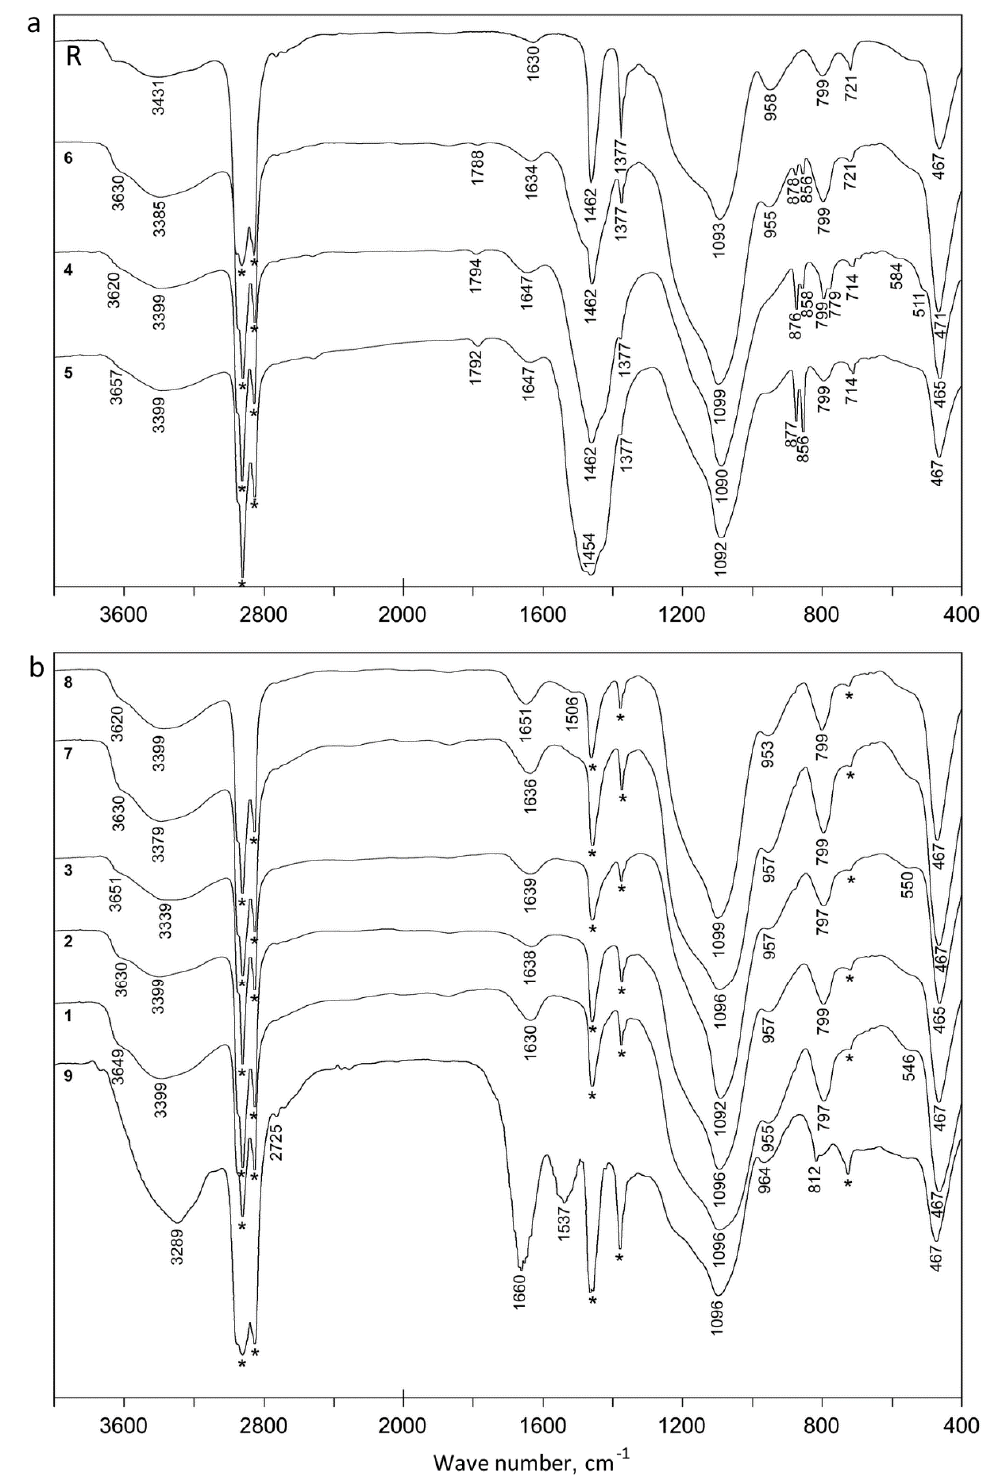
Figure 12. FTIR spectra of the studied samples (numbers according to Table 1, R—reagent silicic acid aqueous GOST 4214-78).